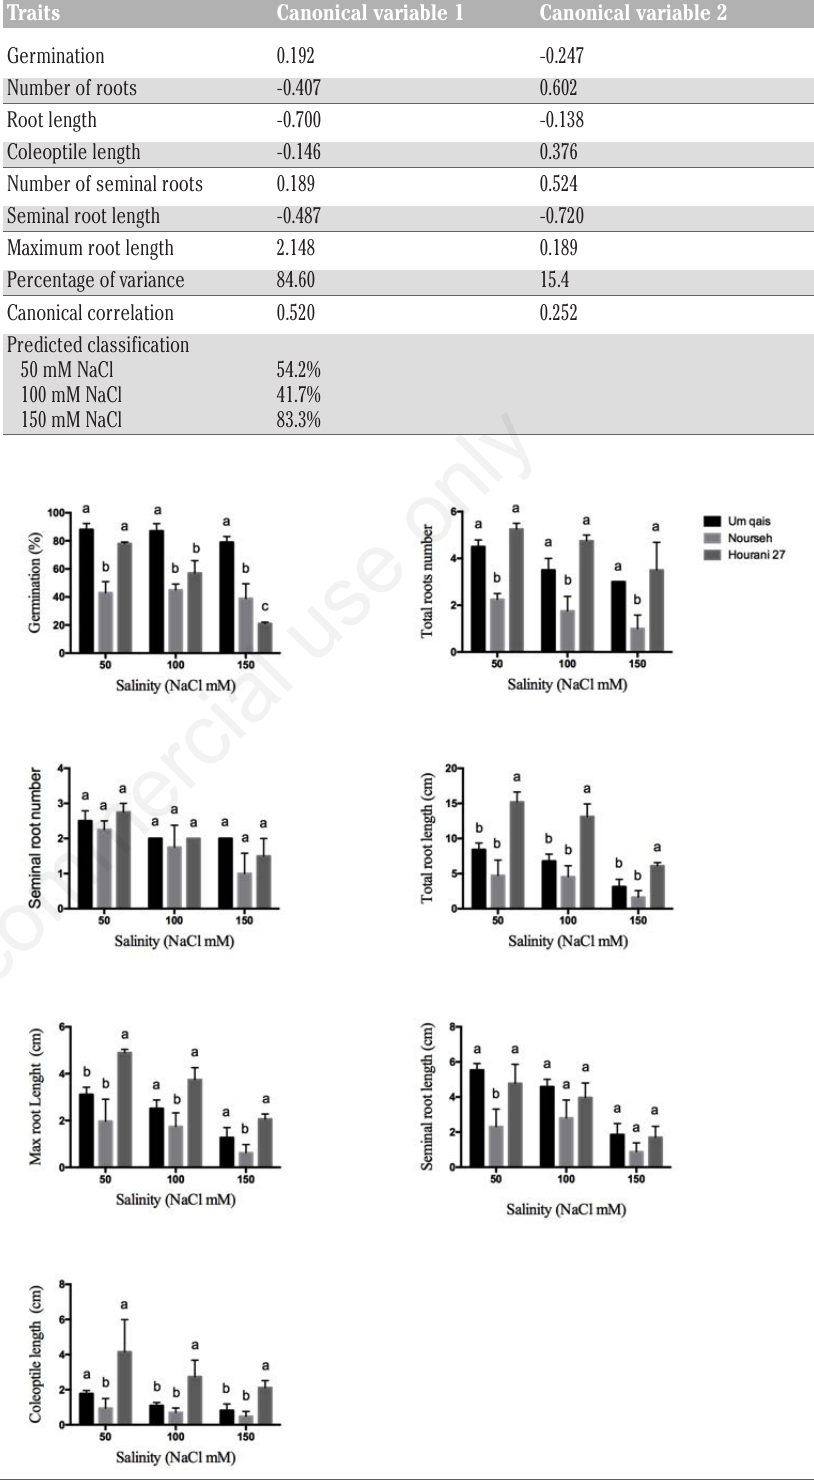
Figure 3. Variation between the landrace and cultivar subgroups of durum wheat in ger- mination percentage and root architectural traits when grown on media containing 50 mM, 100 mM and 150 mM NaCl. Points represent the means ± standard error of four individuals per genotype. Asterisks (*) indicate significant differences at P ≤ 0.05; (**) at <0.01; and (***) at <0.001.